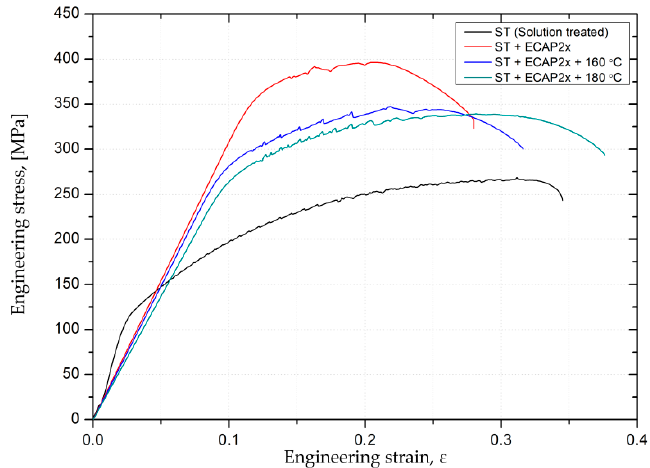
Figure 9. Comparison of engineering stress-engineering strain curves for the AlMg5 alloy subjected to different types of treatments.